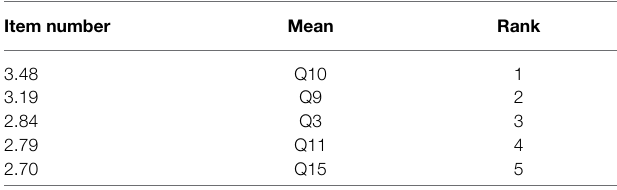
TABLE 2 | The ranks of emotional scaffolding strategies in the teachers’ views. Item number